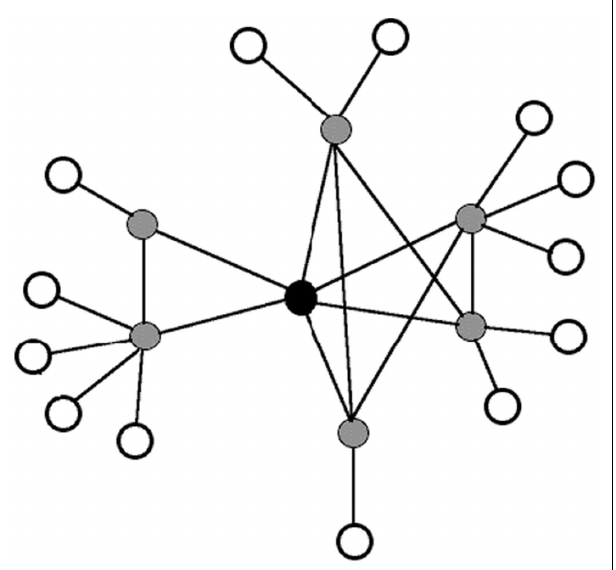
FIGURE 2 |An illustration of a one-hop and two-hop neighborhood. The target node is shown in black, the neighbors of the target node are shown in gray (i.e., one-hop neighbors of the target node), and the neighbors of the neighbors are shown in white (i.e., two-hop neighbors of the target node). For visual clarity, only a few connections among nodes are